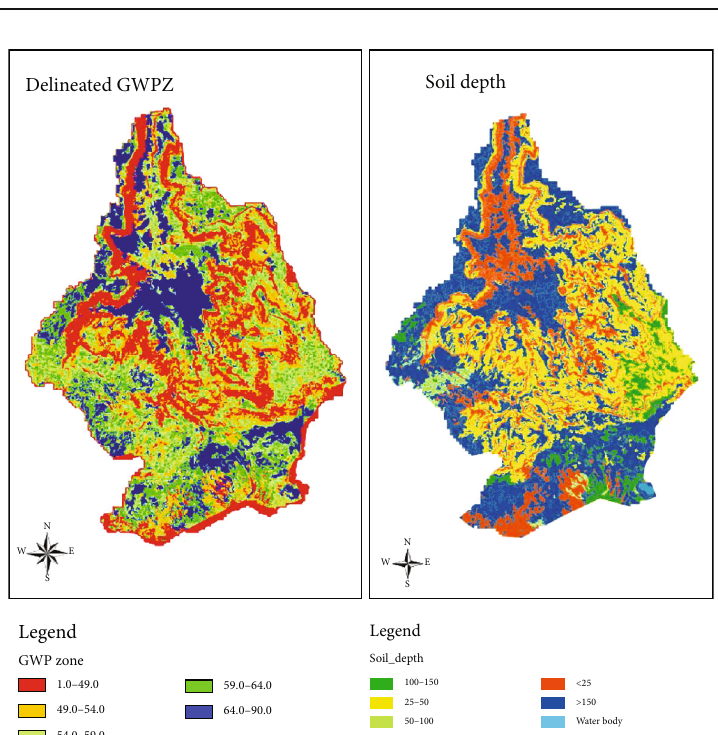
Figure 18: Map showing validation of GWPZs with soil depth.